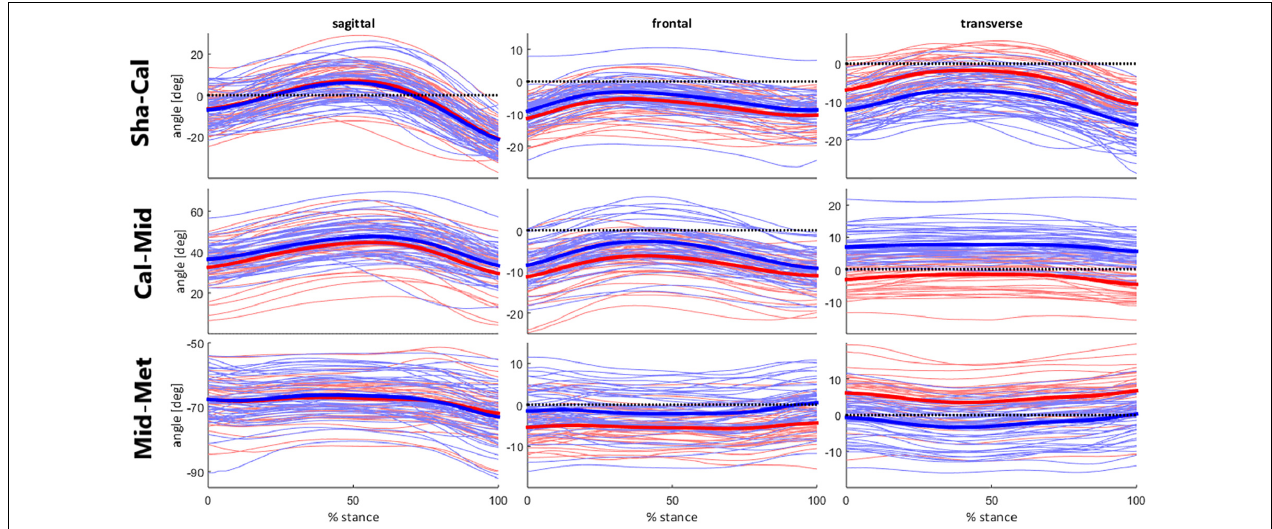
FIGURE 5 | Foot segment joint angles across clusters during stance phase of running. Runners from cluster 1 are represented by the red lines; and from cluster 2, by the blue lines. Mean kinematic waveforms for each cluster are represented by the thick solid